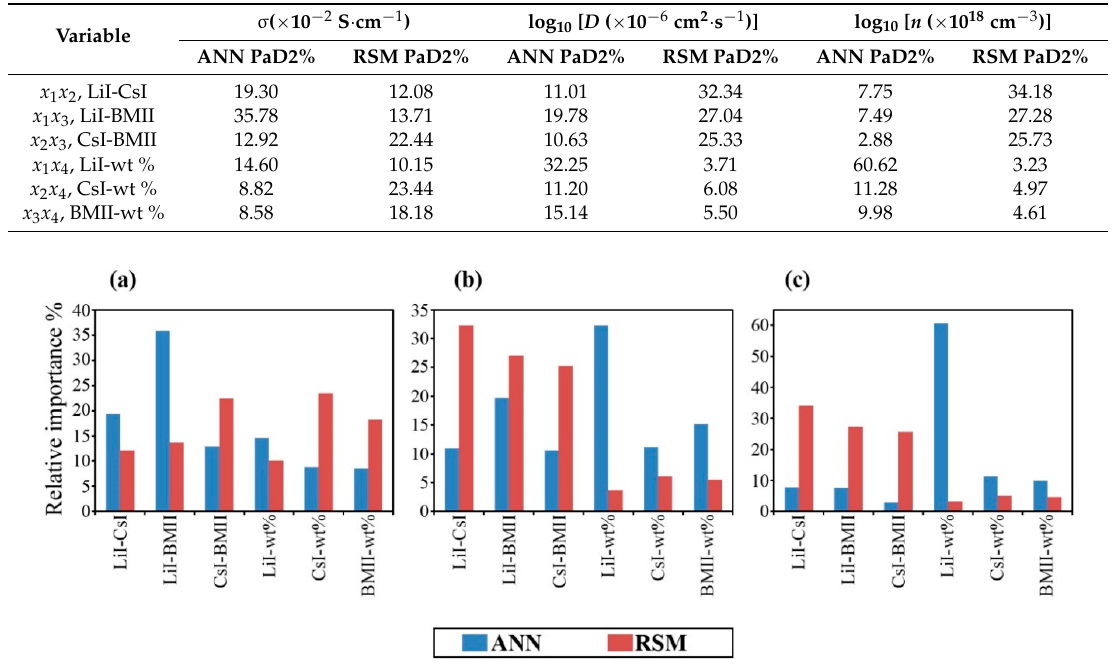
Figure 14. PaD2 relative importance% of two-way interactions towards the output response properties of ( a ) σ (×10 − 2 S·cm − 1 ); ( b ) log 10 [ D (×10 − 6 cm 2 ·s − 1 )]; ( c ) log 10 [ n (×10 18 cm − 3 )].